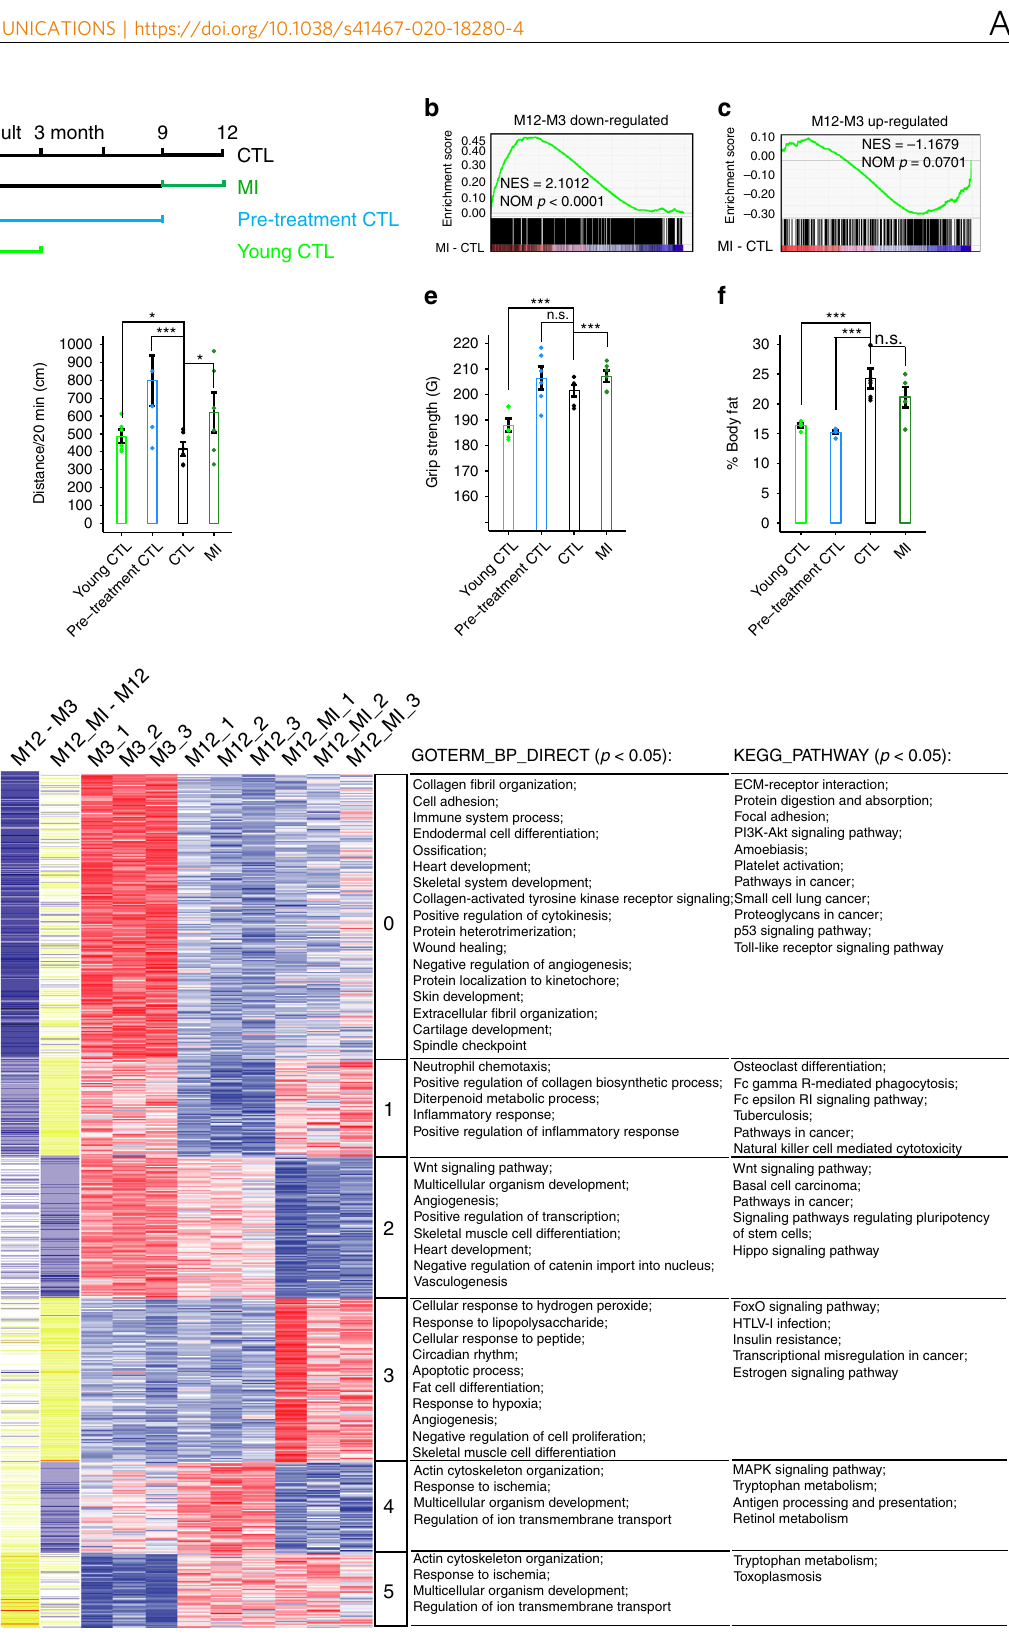
we found LOF of ppk-1 also partially blocked MI ’ s longevity effect (Fig. 4e). In addition, utilizing ELISA assays, we found a trend towards decreased PI(4,5)P 2 level in the worm aging process (albeit insigni fi cant, p = 0.197, and could be reversed by MI treatment ( ** p < 0.01, Fig. 4f).